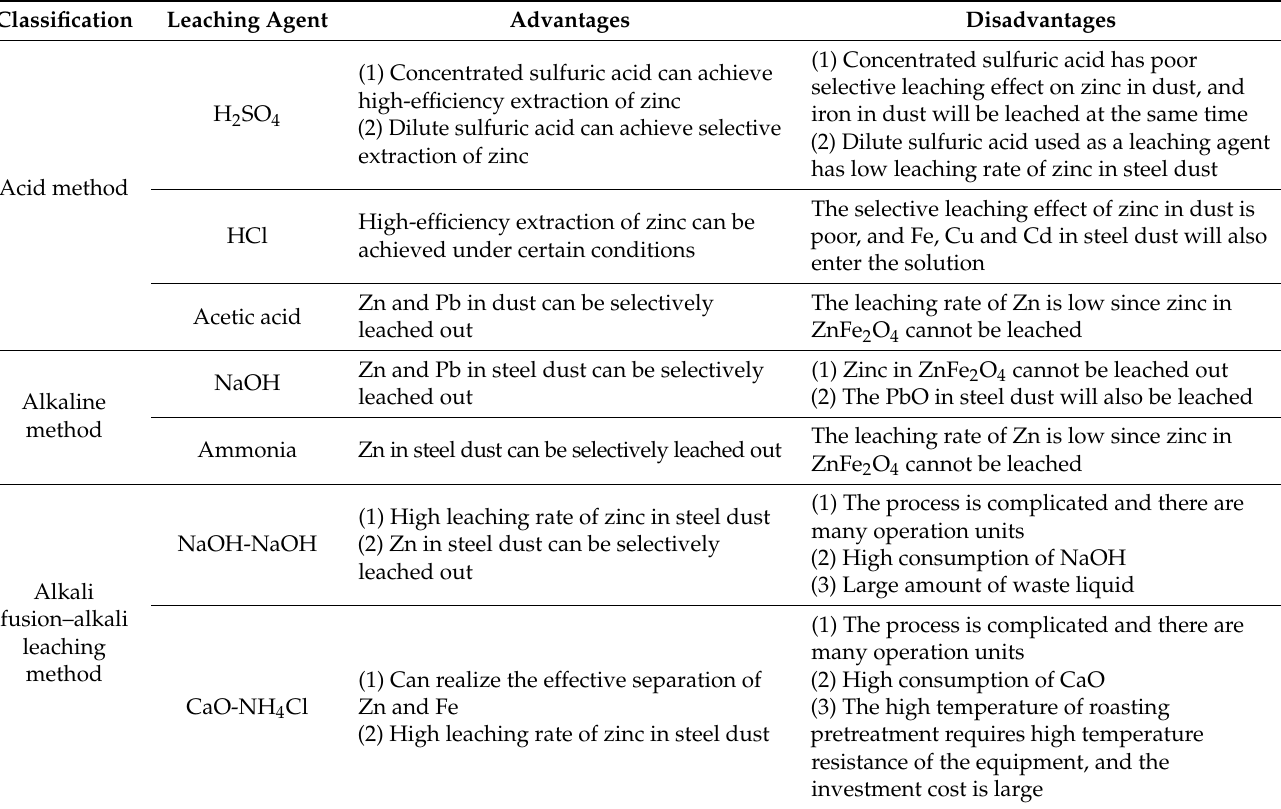
Table 2. Comparison of different hydrometallurgical leaching processes